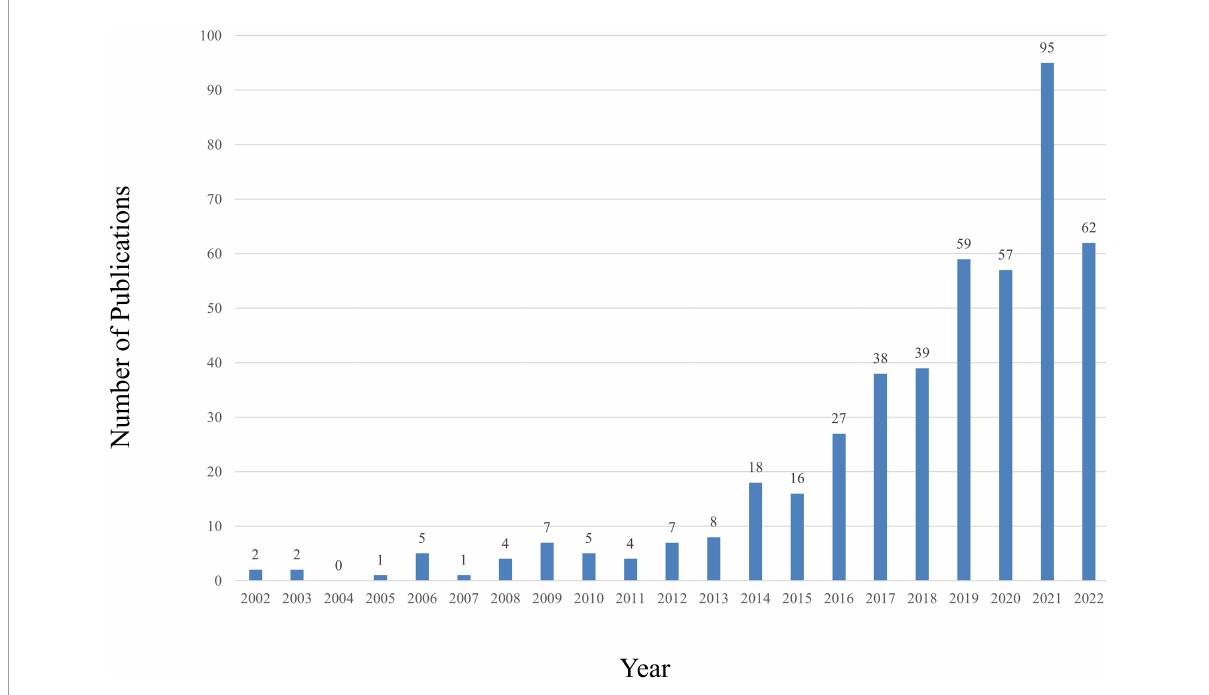
FIGURE2 The number of annual publications relating to research about CHD and gut microbiota from 2002 to 2022.